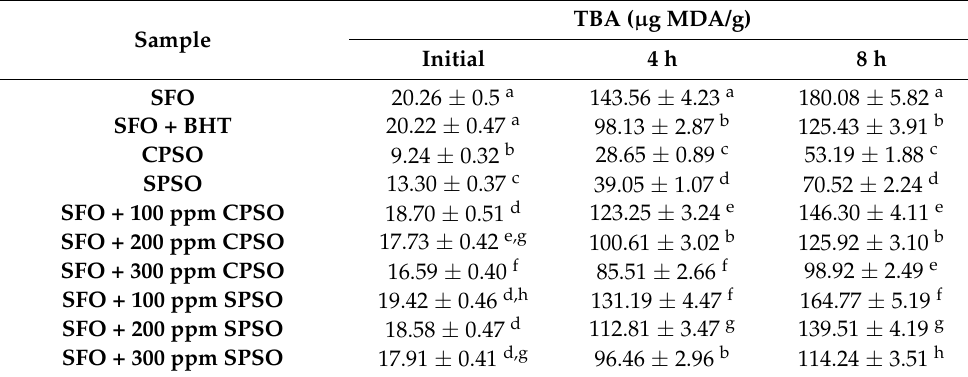
Table 6. Changes in TBA value of oil samples in response to heat